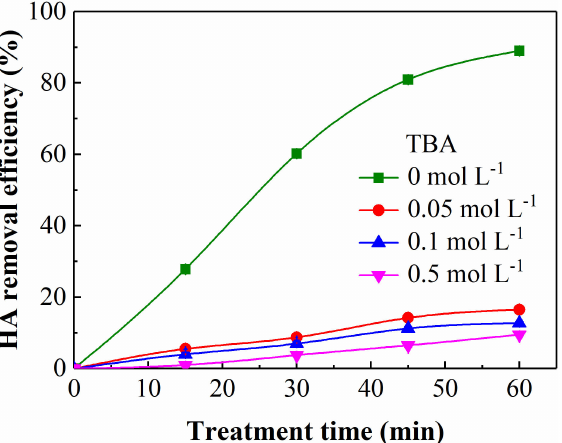
Figure 4. Influence of TBA addition on HA elimination. [HA] 0 = 10 mg L − 1 , [SPB] 0 = 1 mmol L − 1 , pH = 3.